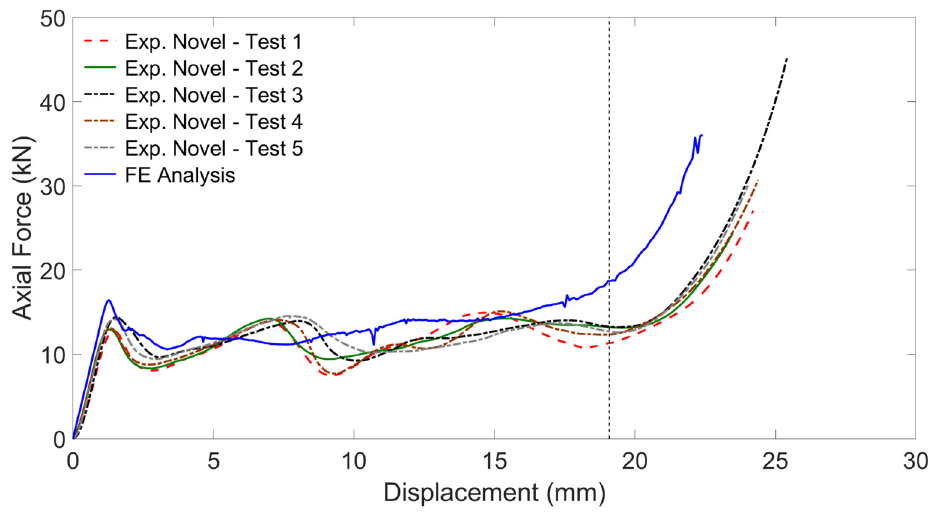
Figure 7. Reaction force versus displacement of the novel cell geometry with regular dimensions under axial loading: experimental and FE curves.